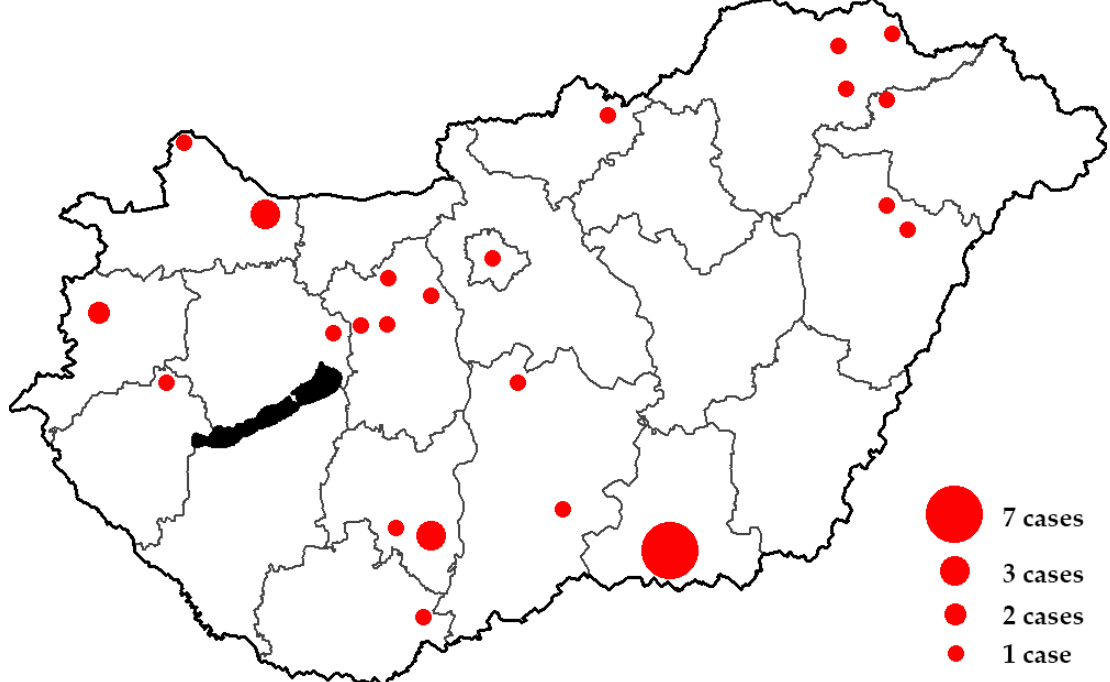
Figure 2. Spatial distribution of human S. suis clinical cases in Hungary (2002–2019) .